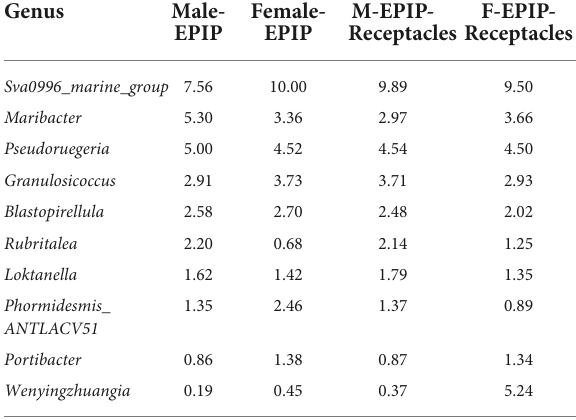
TABLE 3 The top 10 of relative abundances of epiphytic bacteria on algal bodies and receptacles of male and female S. thunbergii at the phylum level (%).